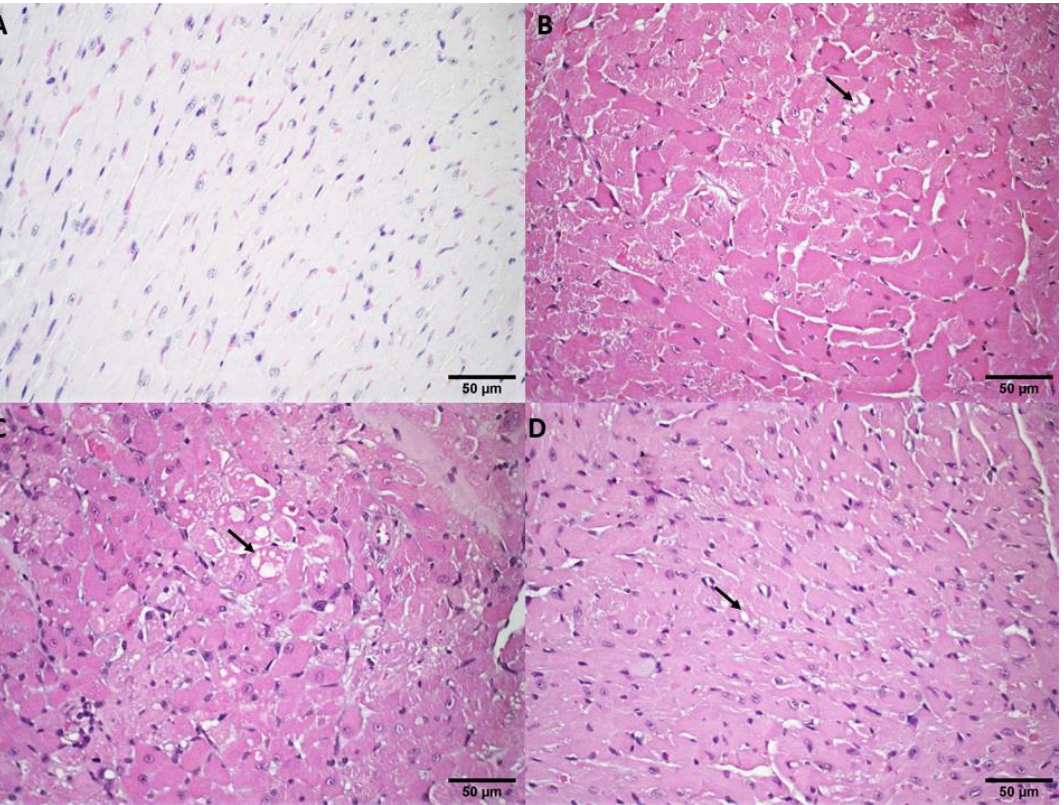
Figure 3. Histological sections of female Balb/c mice heart. ( A ) Represents the control group (HBS). ( B ) Represents the group treated with free DOX at a dose of 10 mg/kg. The arrow indicates the areas of cardiomyocyte vacuolization. ( C ) Represents the group treated with free DOX at a dose of 12.5 mg/kg. The arrow indicates the areas of cardiomyocyte vacuolization that were more intense than ( B ). ( D ) Represents the groups treated with both doses of SpHL-DOX and ExoSpHL-DOX. The arrow indicates the areas of discrete cardiomyocyte vacuolization. HE, scale bar = 50 µm.